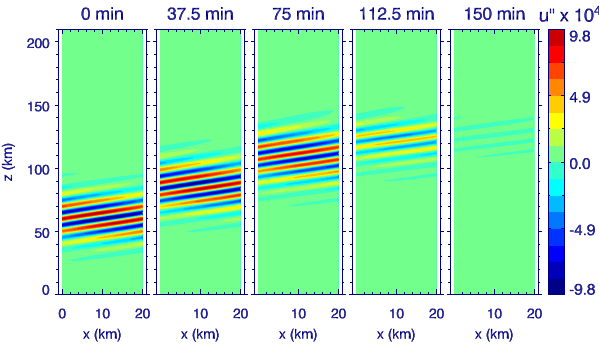
Fig. 3. Snapshots of GW B with initial λ z = 10km (see Table 1) propagating in the isothermal atmosphere with Pr = 1. We show the square root of the density-weighted horizontal wind disturbances (ms − 1 ) at times of 0, 37.5, 75, 112.5, and